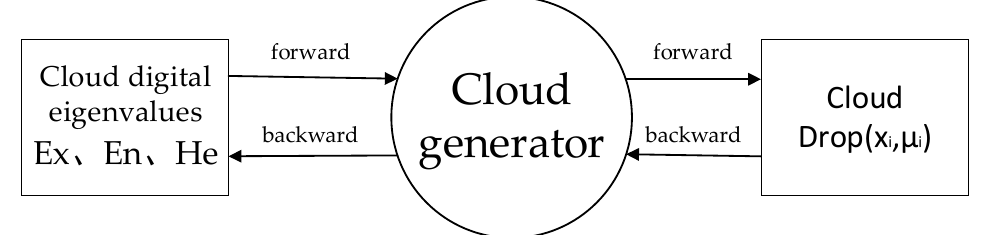
Figure 4. Cloud generator operation schematic.